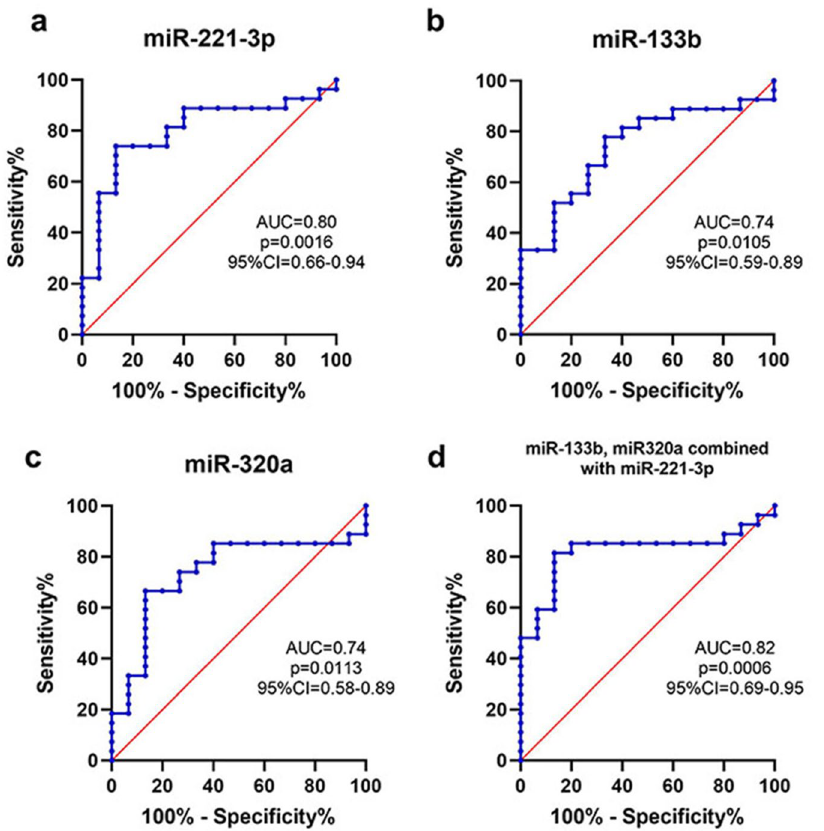
Figure 3. ROC analysis of plasma miRNAs as PD biomarkers. ( a - d ) ROC curves of miR-221-3p ( a ), miR-133b ( b ), miR-320a ( c ) and combination of these three miRNAs ( d ) for discriminating patients with PD (n = 27) from healthy controls (n = 15) in cohort 2. PD, Parkinson’s disease.